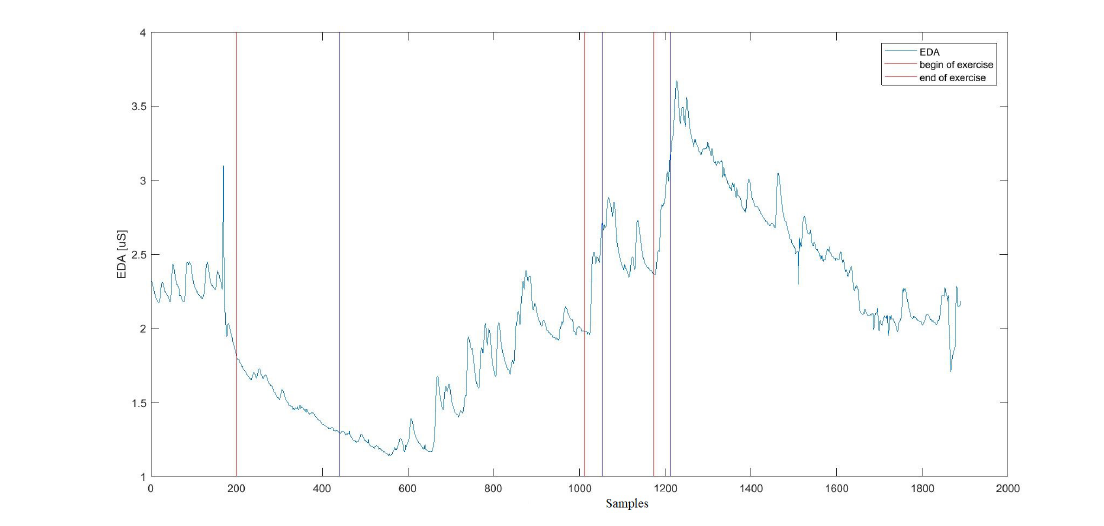
Figure 4. Electrodermal Acvitity (EDA) signal with marked time markers indicating the beginning and end of the exercises: analysed time intervals.